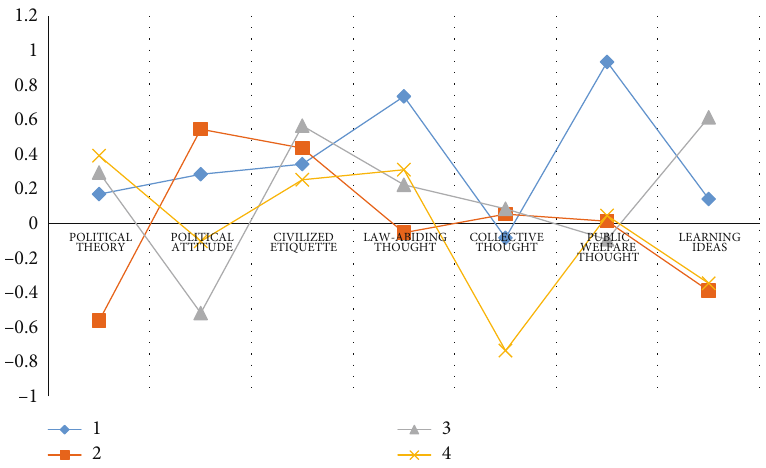
Figure 8: Principal component load of college students ’ ideological and moral